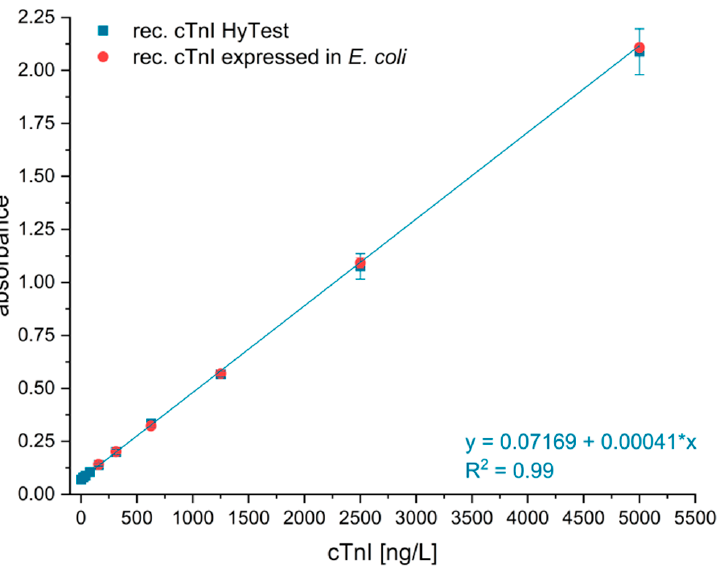
Figure 6. Quantification of cTnI expressed in E. coli using commercially available cTnI (Hytest 8RTI7) was used to calibrate the sandwich ELISA, as recommended by the supplier [31] .